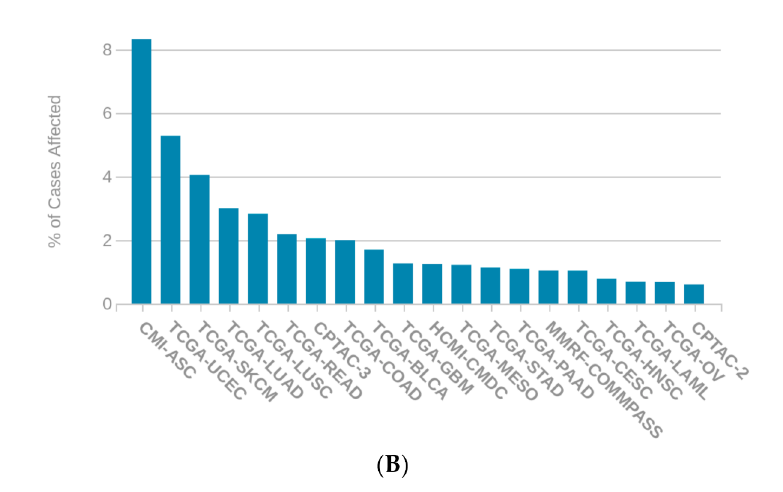
Figure A5. CNV and mutation distribution of PDL1 (CD274) in different cancer types. ( A ) CNV distribution. ( B ) Mutation distribution.